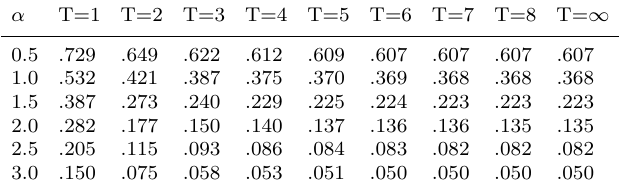
Table 2. Comparison of P T ( D = 0) with P ∞ ( D = 0) α